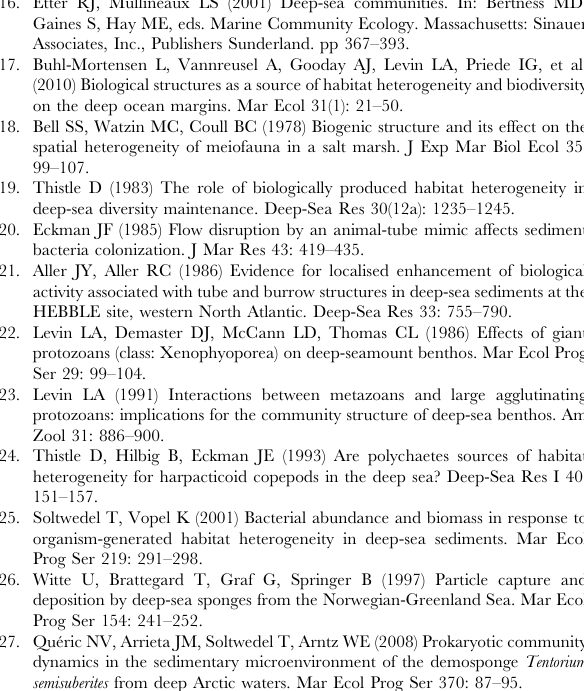
Table S1 Nematode genera and families identified in control and sponge samples (mean values including standard deviation,